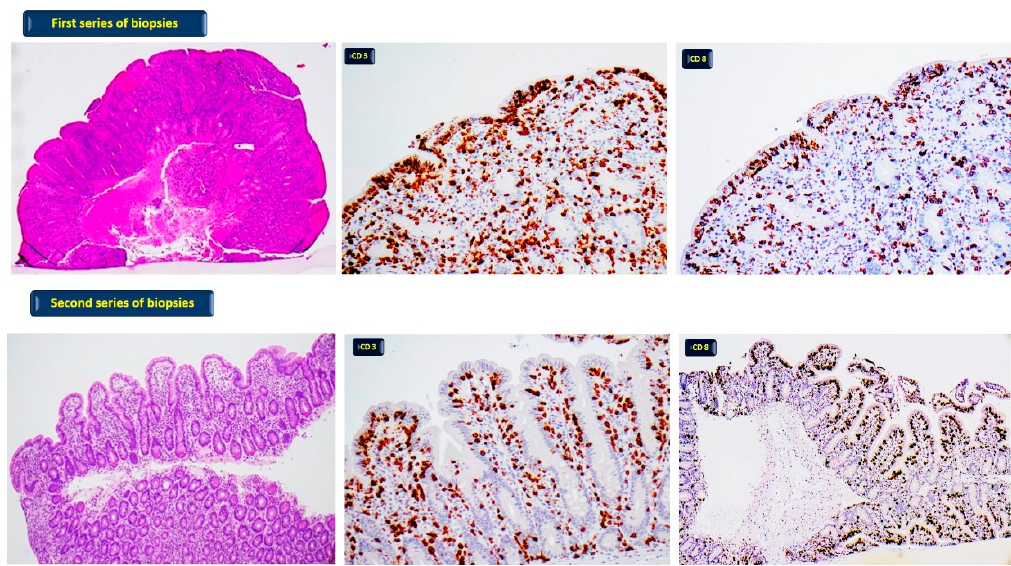
Figure 1. First series of biopsies: patient without GFD; diffuse moderate-severe atrophy of villi (haematoxylin-eosin 40×) with pathological increase of T lymphocytes CD3 (400×) and CD8 positive (400×). Second series of biopsies: patient on GFD; normal villi with focal low atrophy (haematoxylin-eosin 100×) and pathological increase of T lymphocytes CD3 (400×) and CD8 positive (100×).